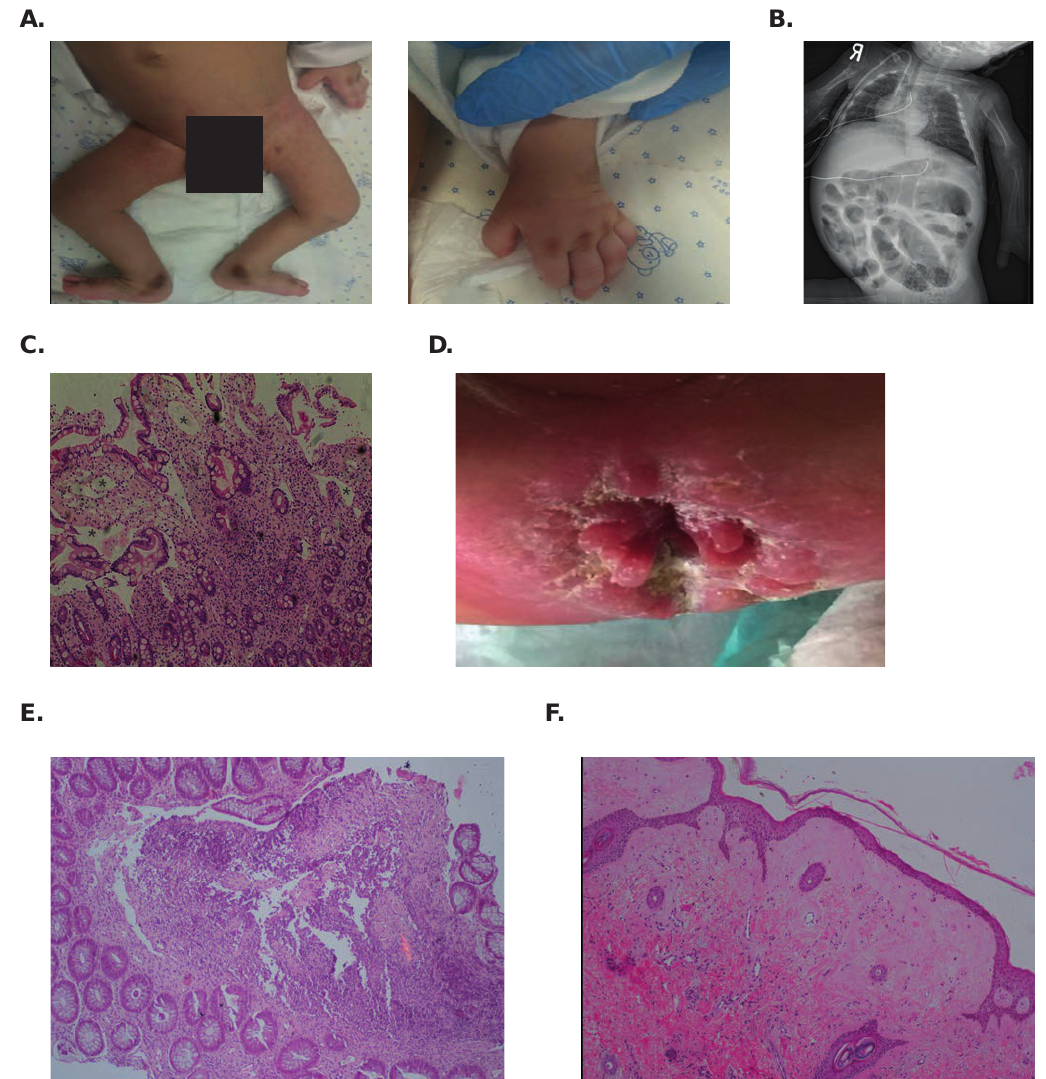
Figure 1. Clinical presentation of patients with ANTXR2 deficiency. ( A ) Hyperpigmentation regions over median malleolus and over the knuckles in both hands of Patient 1. ( B ) Abdominal X-ray of Patient 1 showing marked bowel distention. ( C ) H & E stain of duodenal biopsy of Patient 1 showing distortion of architecture and dilation of lymphatics compatible with lymphangicetasia, marked by asterix. ( D ) Perianal thickened nodules observed in Patient 2. ( E ) H&E stain of colonic biopsy from Patient 2 showing abnormal architecture and marked hyalinosis. ( F ) H&E stain of skin biopsy from Patient 2 demonstrating pink homogeneous acellular material throughout the dermis, suggestive of